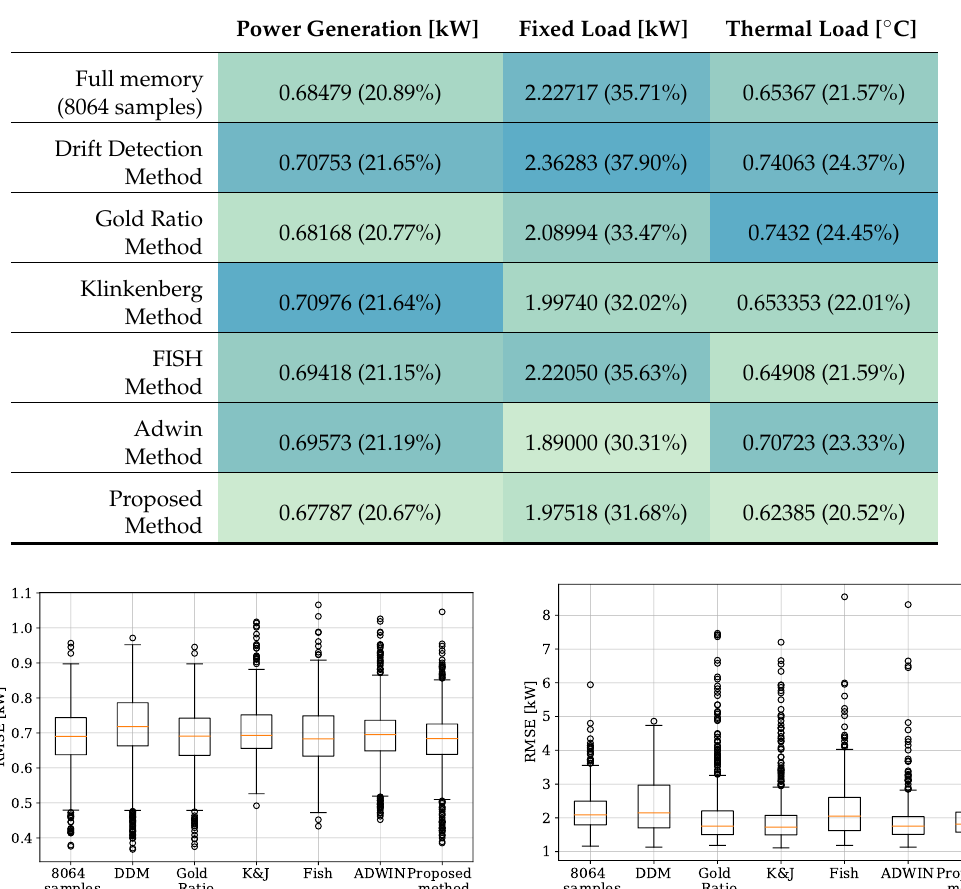
Table 1. Average RMSE and Average NRMSE for a spring day.